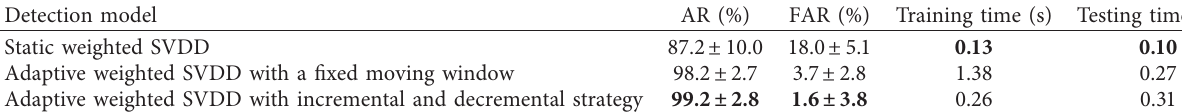
Table 2: Comparison of different weighted SVDD methods.